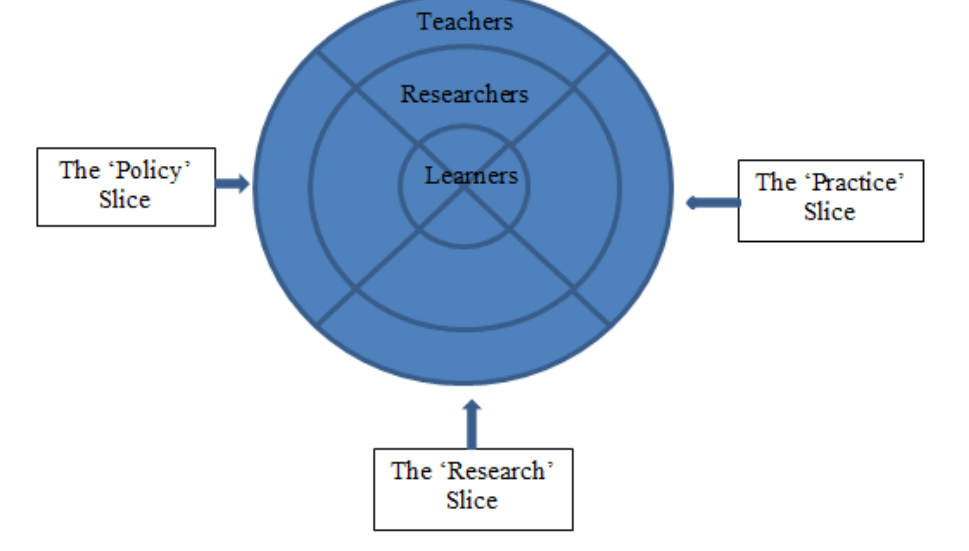
Figure 1. A relationship of actors and